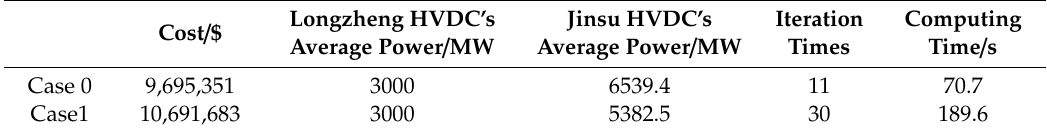
Table 5. Operating cost and HVDC